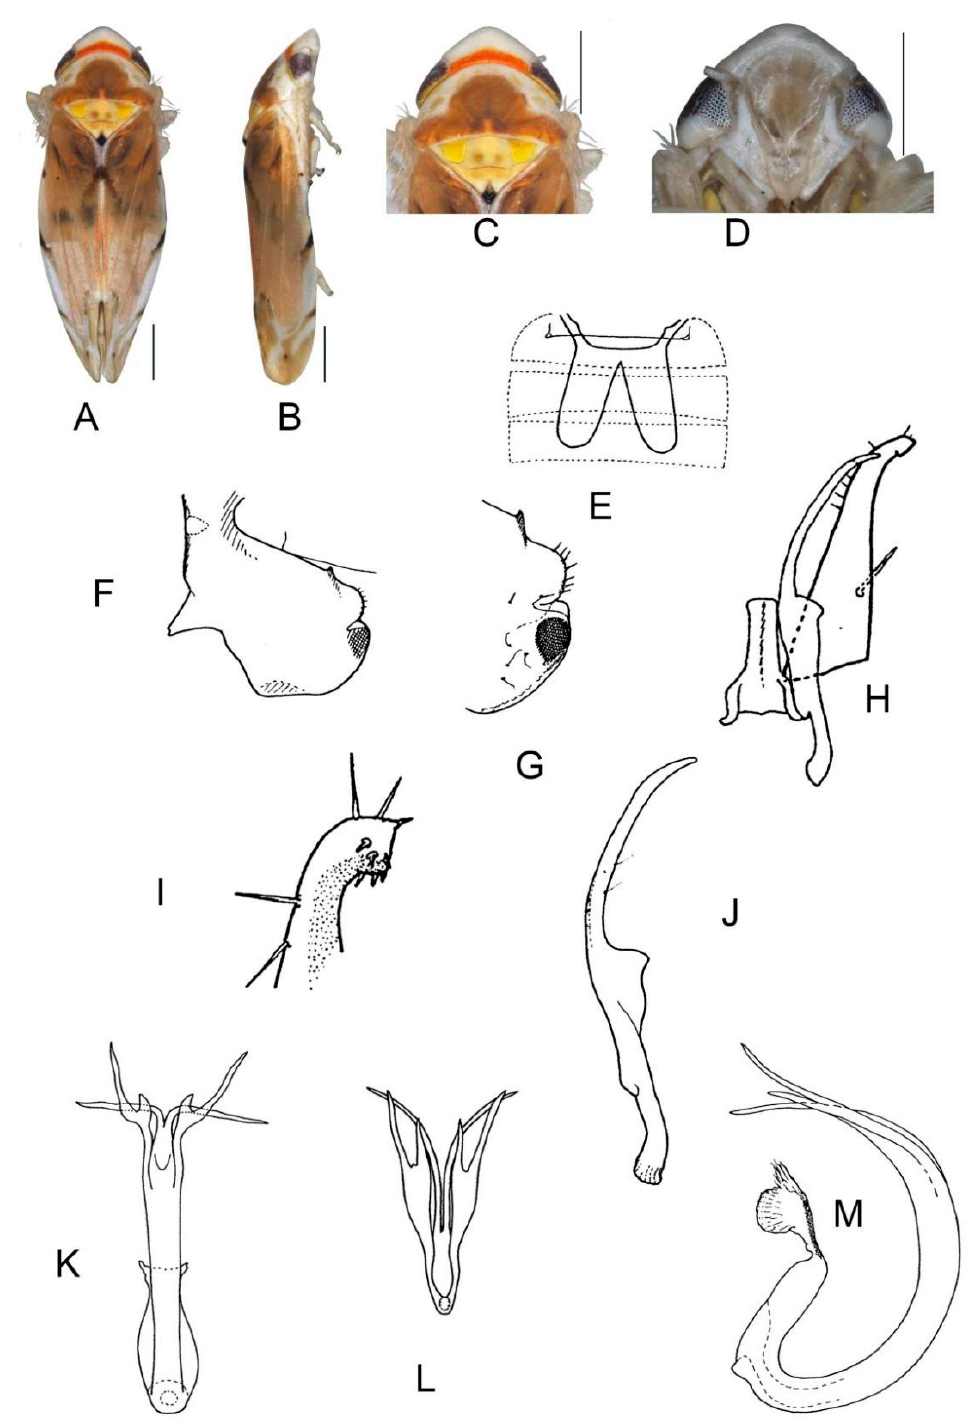
Figure 19. Eurhadina ( Singhardina ) rutilans : ( A ) habitus, dorsal view; ( B ) habitus, lateral view; ( C ) head and thorax, dorsal view; ( D ) face; ( E ) abdominal apodemes, dorsal view; ( F ) male pygofer side, lateral view; ( G ) hind part of pygofer, lateral view; ( H ) subgenital plate, connective and paramere, dorsal view; ( I ) apex of subgenital plate, dorsal view; ( J ) paramere, dorsal view; ( K ) aedeagus, posterior view; ( L ) apex of aedeagal shaft, dorsal view; and ( M ) aedeagus, lateral view. Scale bars: 0.5 mm.